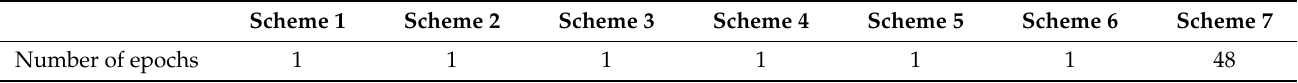
Table 5. The epoch numbers of ambiguity initialization of several schemes for the dynamic Table 4. The solution rate of the seven schemes for the dynamic data.